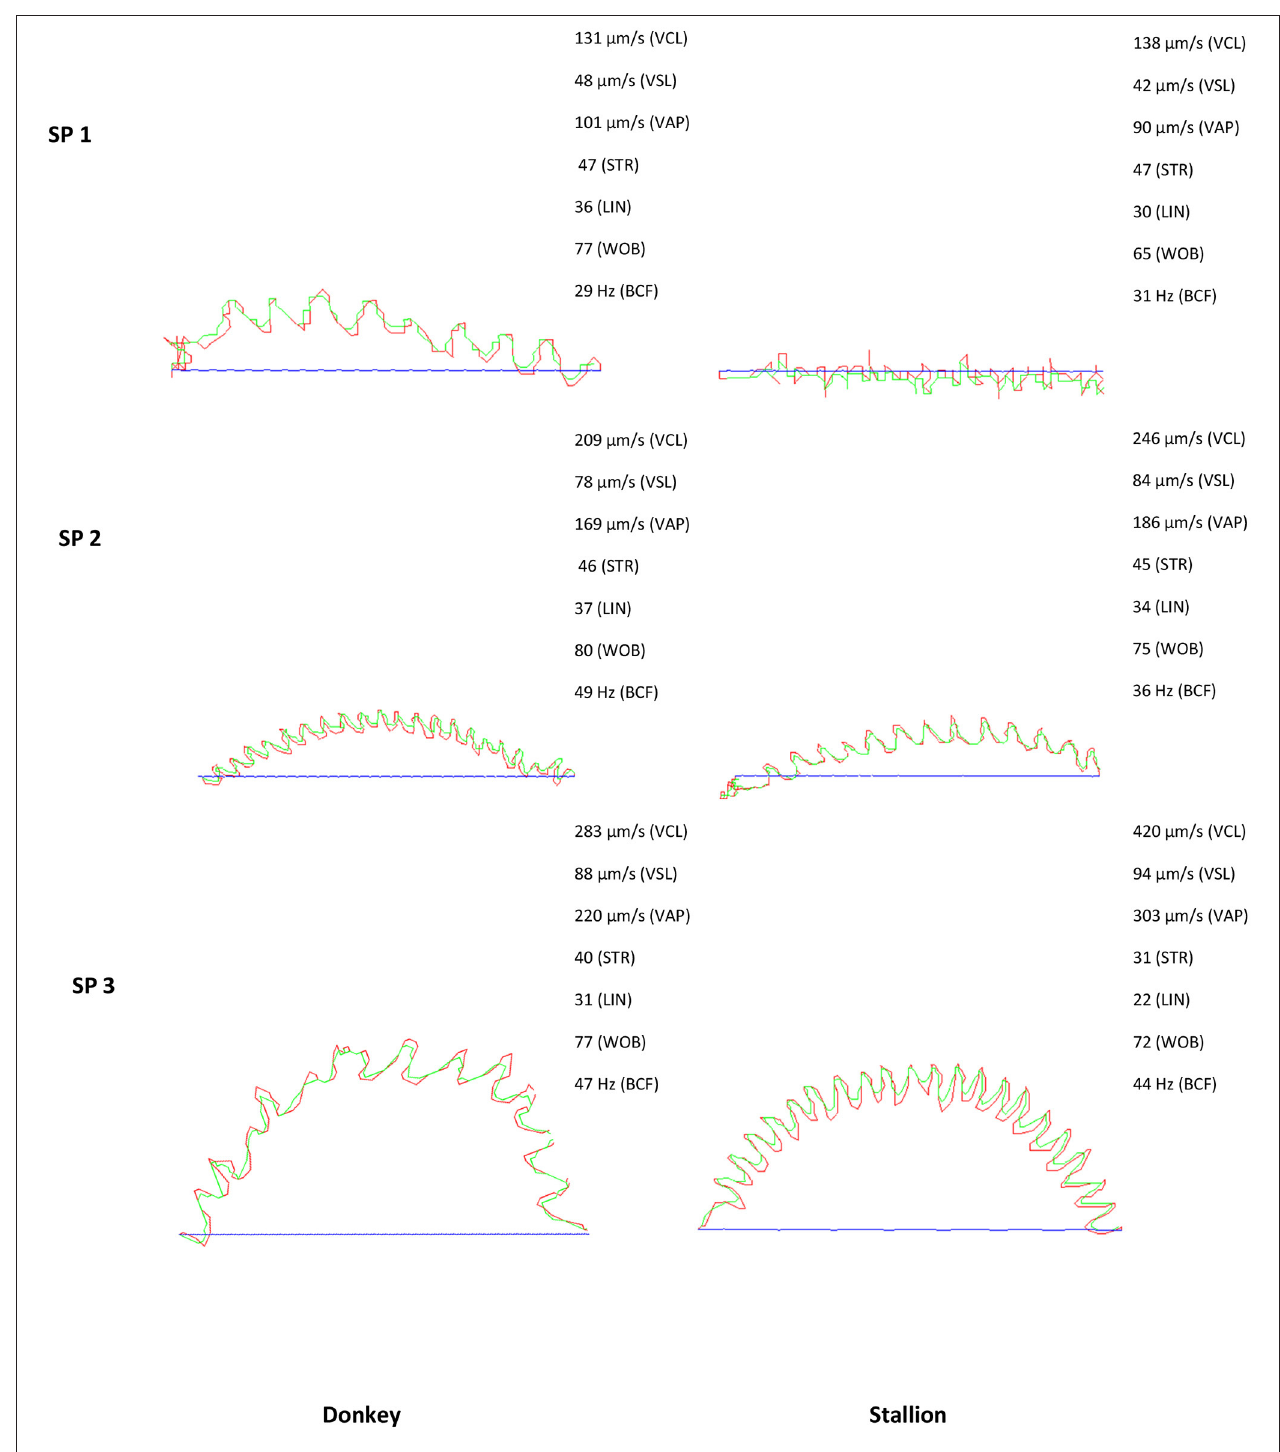
FIGURE 1 | Sperm trajectory of the three subpopulations encountered in stallion and donkey semen SP; sperm subpopulation, Blue line: Straight line velocity (VSL), red line: Curvilinear velocity (VCL); green line: Average path velocity (VAP); straightness (STR); Lineality (LIN); Wobble (WOB); Beat cross frequency (BCF).